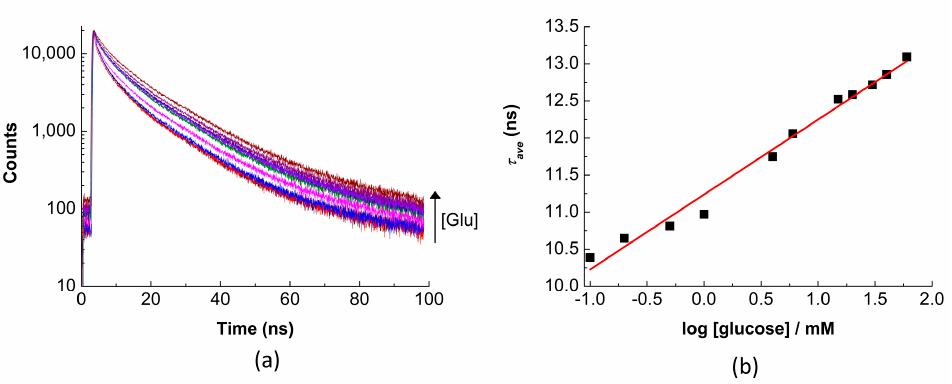
Figure 4. ( a ) PL decay traces ( λ ex = 440 nm, λ em = 520 nm) of QD–APBA nanosensors in solutions containing a different concentration of glucose (phosphate buffer 10 mM pH 9). ( b ) Calibration plot: PL average lifetime values calculated from the decays versus the logarithm of the concentration of glucose.